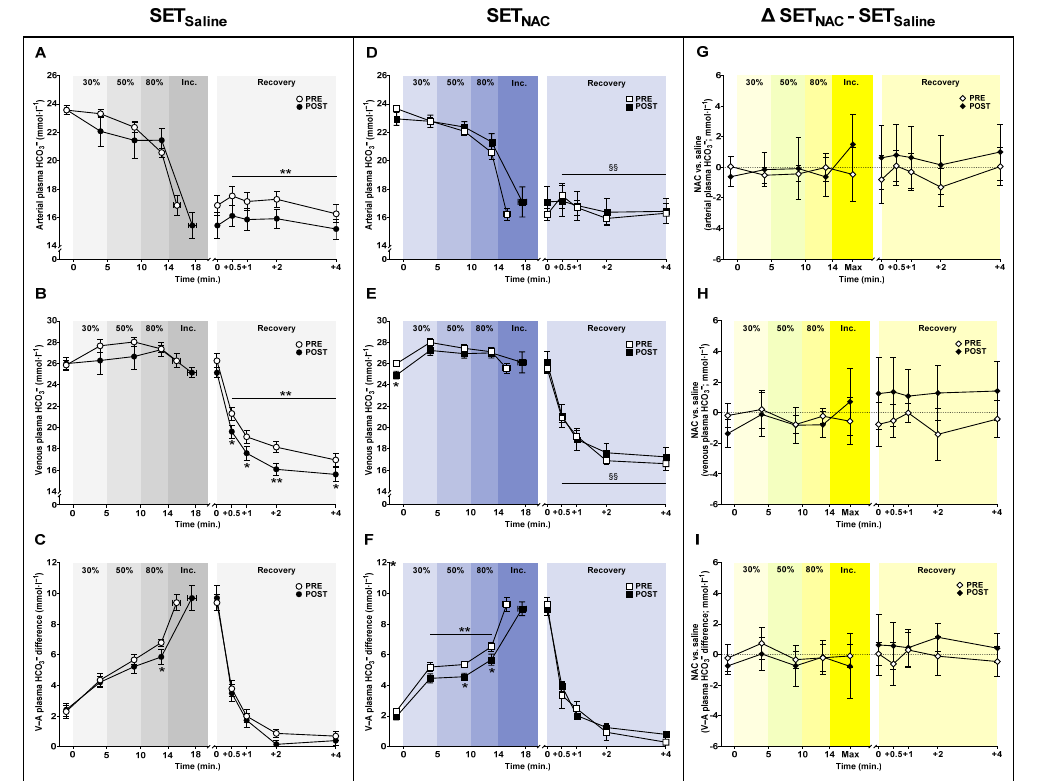
Figure 6. Effect of speed endurance training (SET) on plasma HCO 3 − shifts without and with N - acetylcysteine infusion. Plasma HCO 3 − concentrations ( A – F ) before, during, and after knee-extensor exercise without (SET Saline , n = 10) and with N -acetylcysteine (SET NAC , n = 9) infusion as well as differences ( ∆ ) between SET NAC and SET Saline ( G – I , n = 9) before (pre) and after (post) SET. ** Post different from pre ( p < 0.01). * Post different from pre ( p < 0.05). §§ Trial × leg effect ( p < 0.01). Data are presented as mean ± SEM (SET Saline and SET NAC ) or mean ± 95% CI ( ∆ SET NAC − SET Saline ). The mean venous-arterial plasma [HCO 3 − ] difference during submaximal exercise was non-significantly lower and lower after training in SET Saline ( p = 0.072) and SET